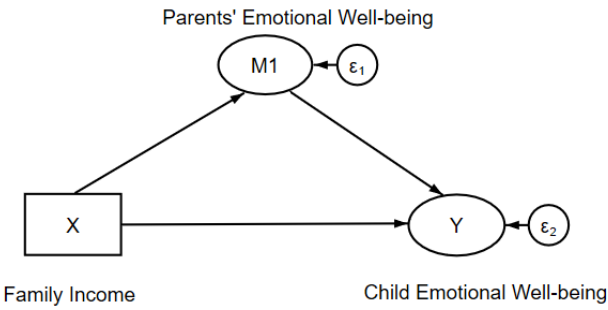
Figure 1. Conceptual model of the mediation effect of parents’ emotional wellbeing.